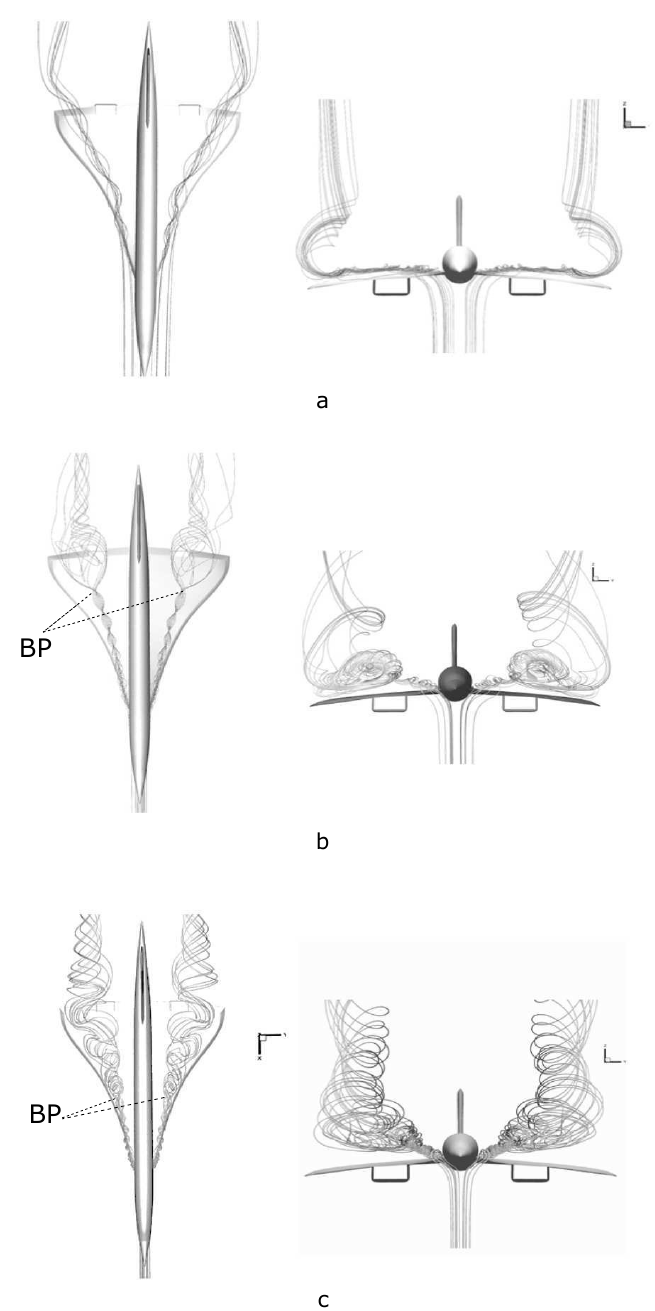
Figure 15. Flowfield streamlines at ( a ) α = 10 ◦ , ( b ) 20 ◦ , and ( c ) 30 ◦ . As shown, the flowfield over the wing assumes a complex topology as soon as the AoA